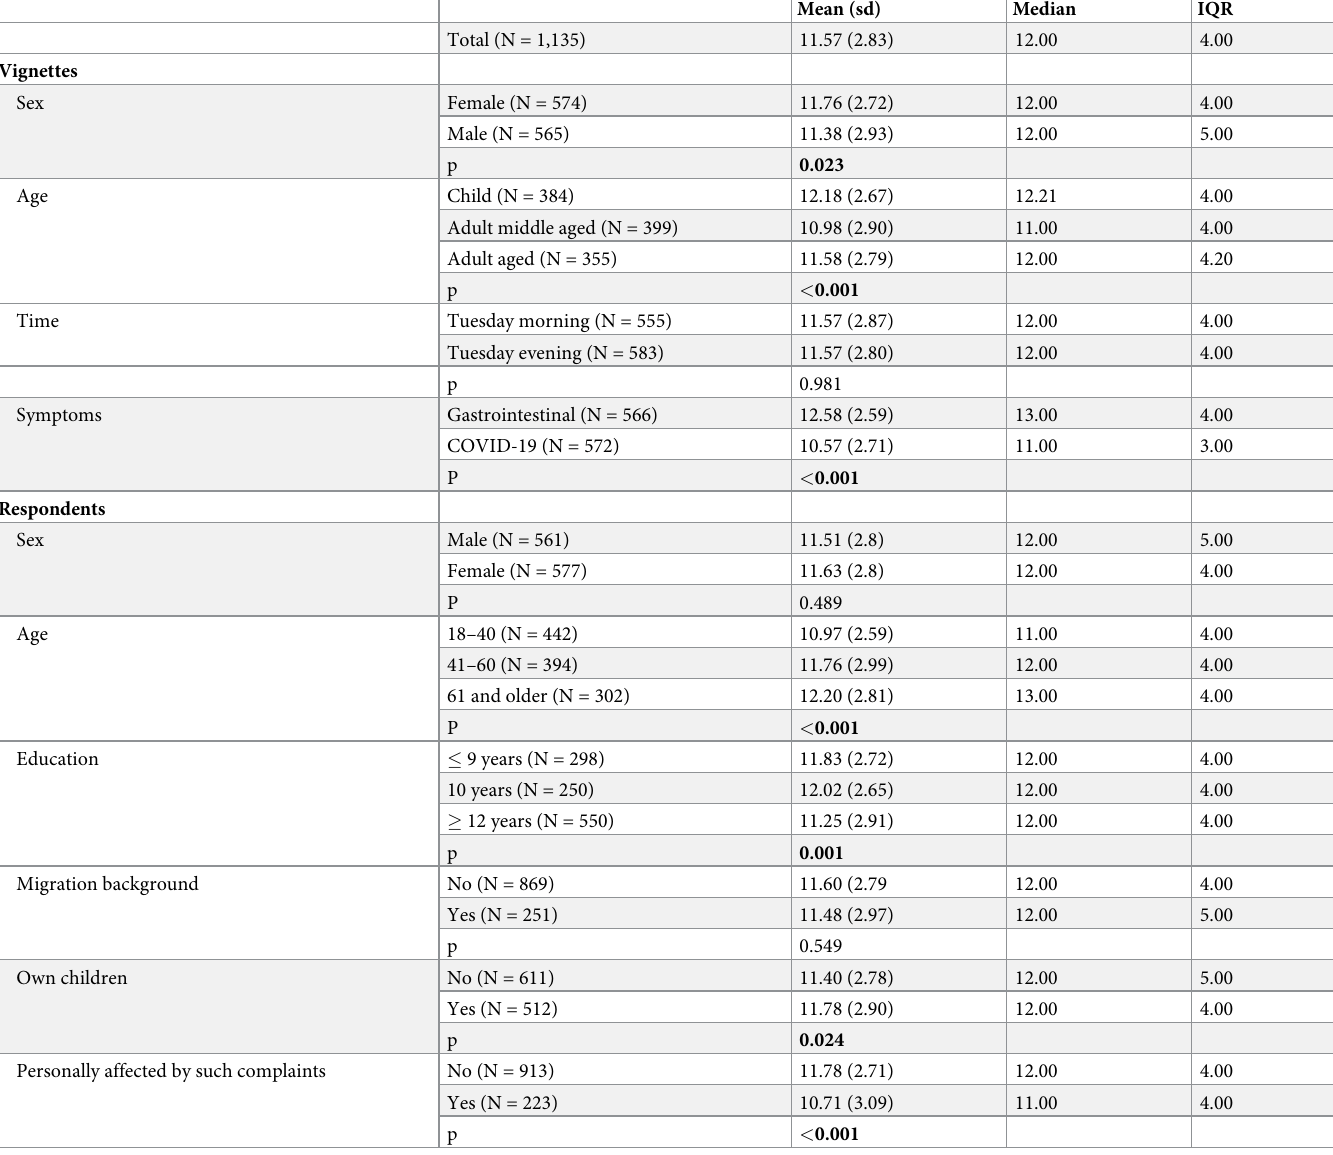
Table 2. Descriptive analysis of perceptions of urgency of symptoms (sum scale, range 4–16)–results of t-tests and ANOVA 1,2